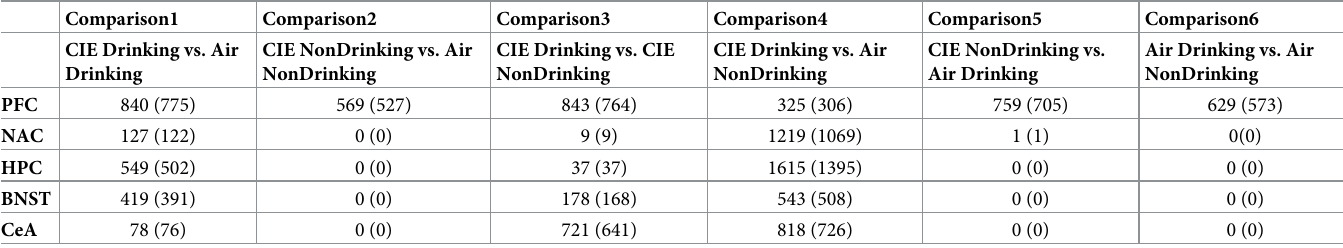
Table 1. Differentially expressed probesets and genes for comparisons across all treatment groups.